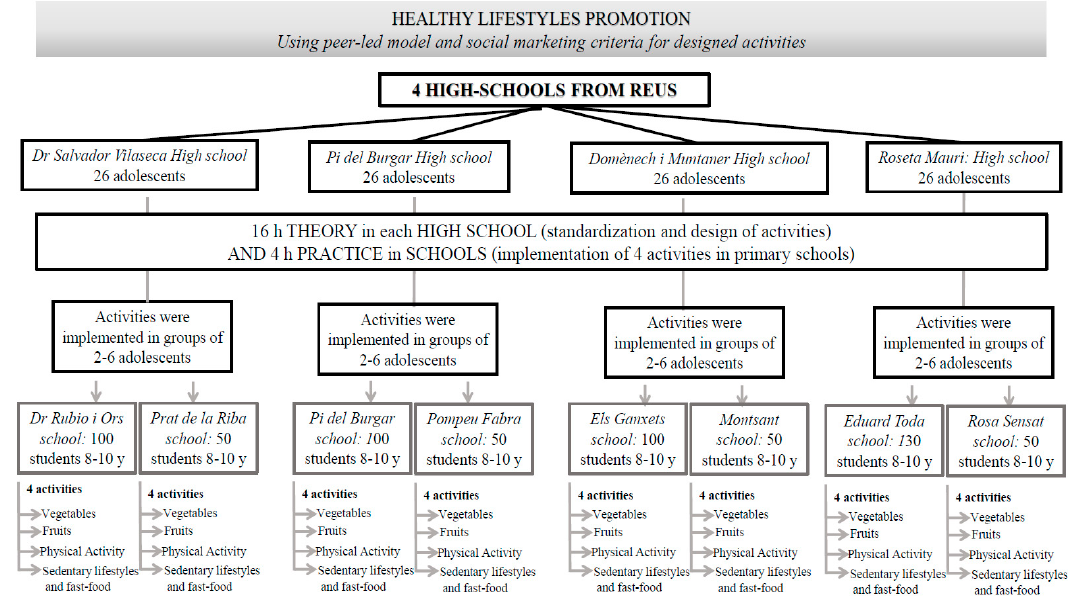
Figure 2. Implementation of the EYTO-kids (European Youth Tackling Obesity in Adolescents and Children) activities.